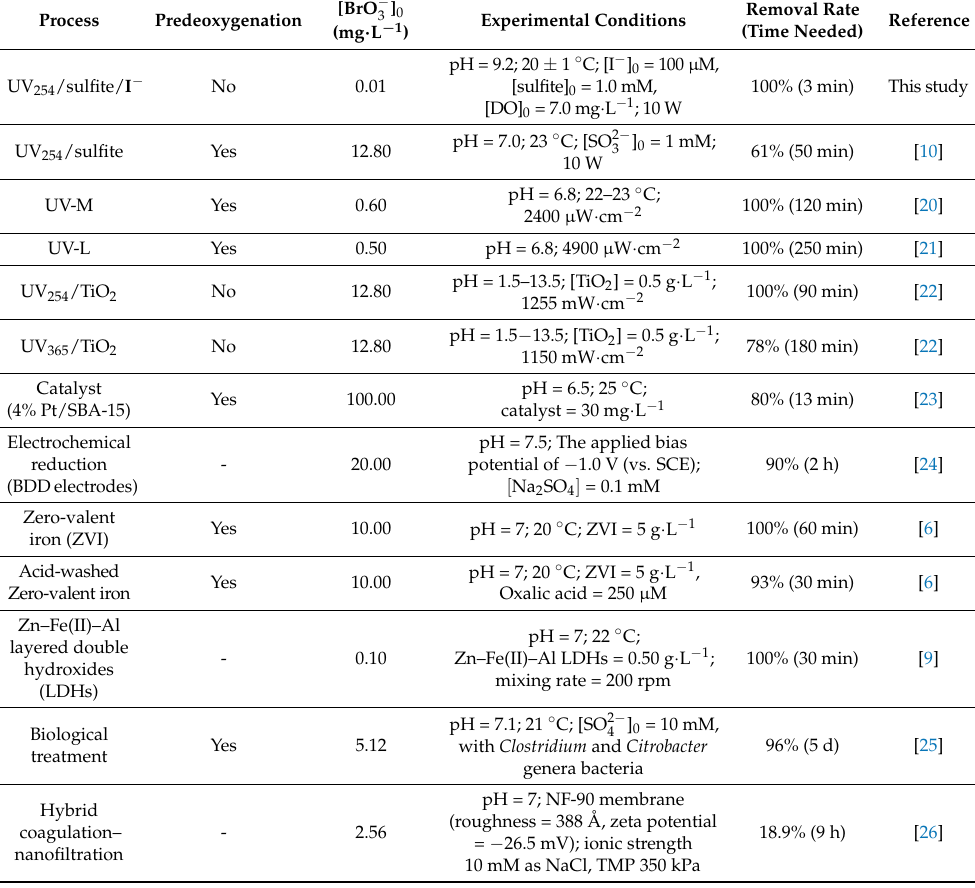
Table 1. Comparison of bromate removal efficiency with different processes. UV—ultraviolet; BDD—boron-doped diamond; SCE—saturated calomel electrode; TMP—transmembrane pressure. Process